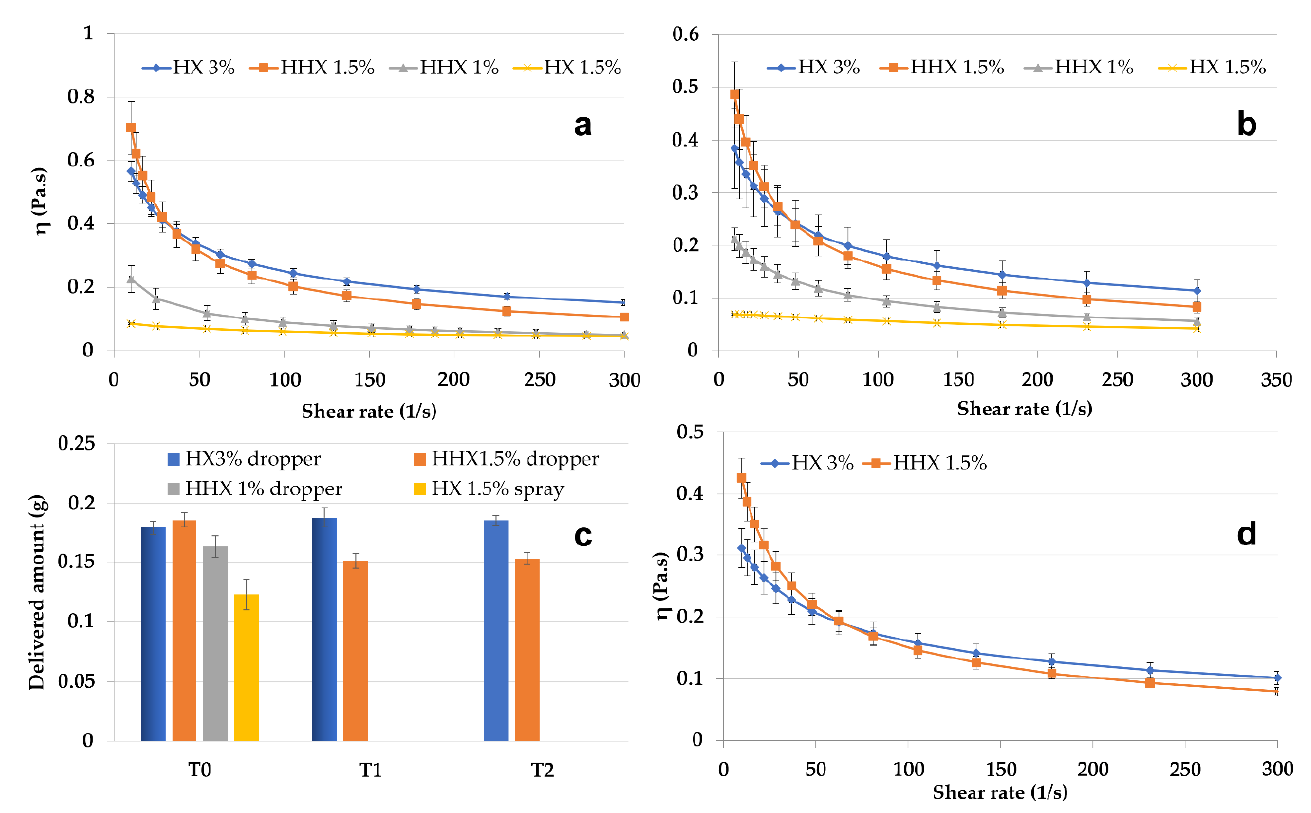
Figure 5. Viscosity curves of CSO–CO 50 diluted to 1:1 w / w with HEC low (HX) and high (HHX) molecular weights at different concentrations at 25 °C ( a ) and 32 °C ( b ) (mean ± sd; n = 3). Delivered amounts of HHX 1% and HX 1.5% through VP6 dropper and VP6 spray devices at T0 and after 1 week (T1) and 2 weeks (T2) ( c ) (mean ± sd; n = 10). Viscosity curves of the two most viscous samples, HX 3% and HHX 1.5%, at 37 °C ( d ) (mean ± sd; n = 3).